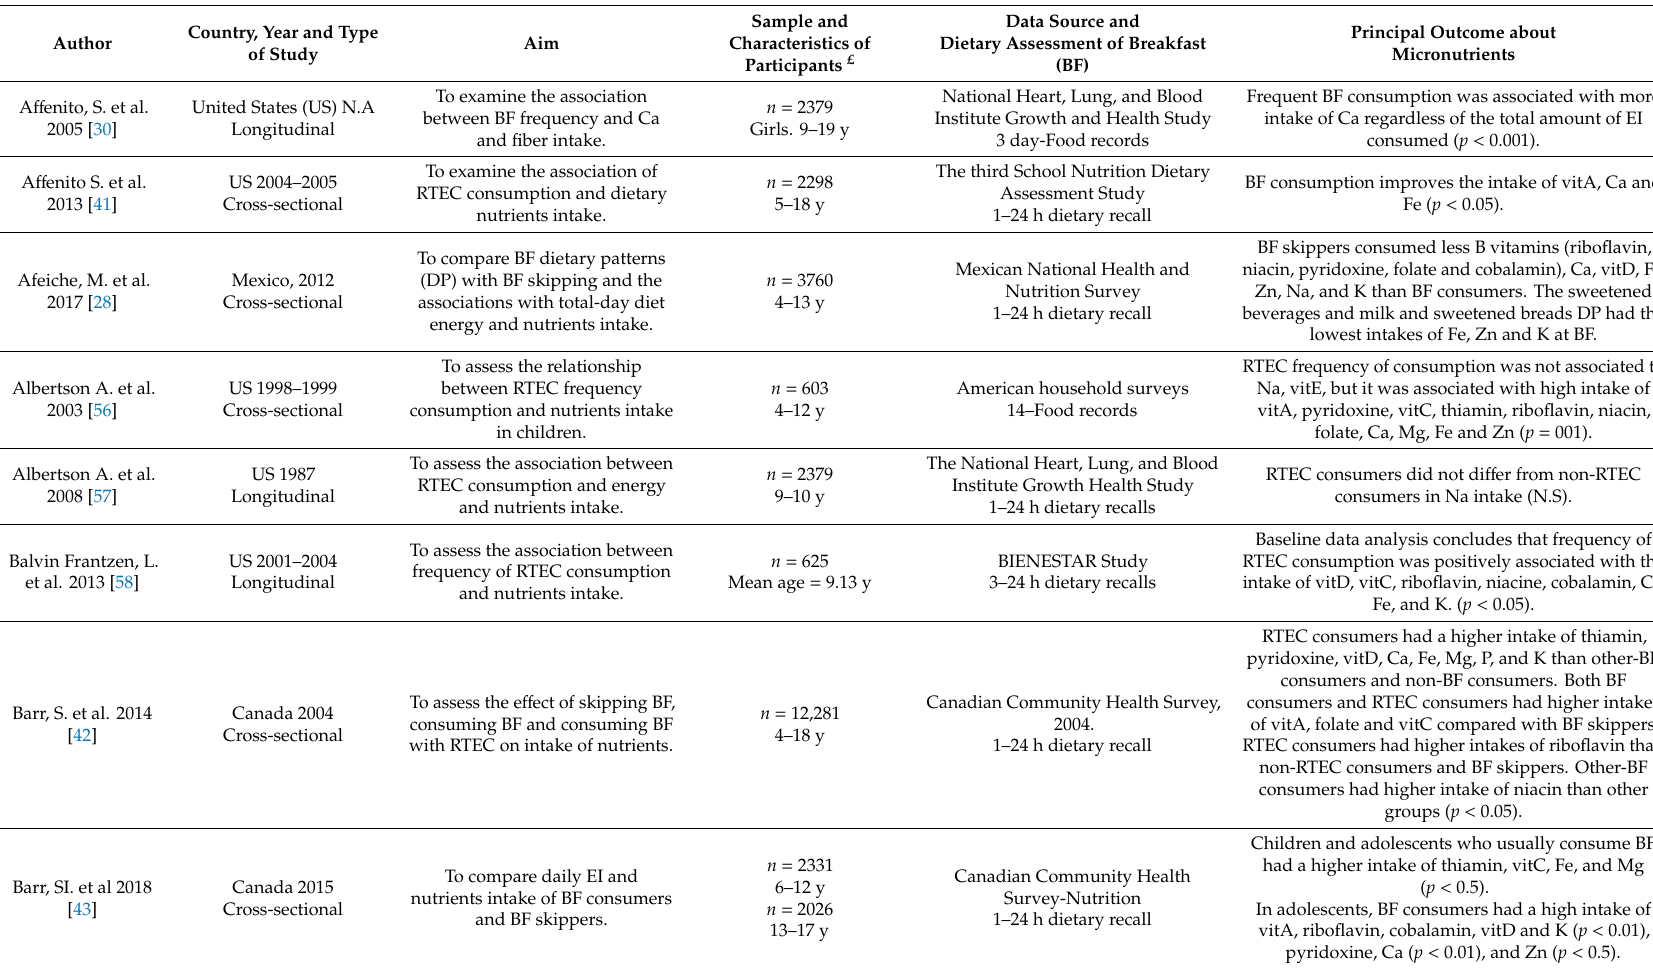
Table 3. Characteristics, description and summary of outcomes of articles included in the systematic review (SR) on breakfast and micronutrients